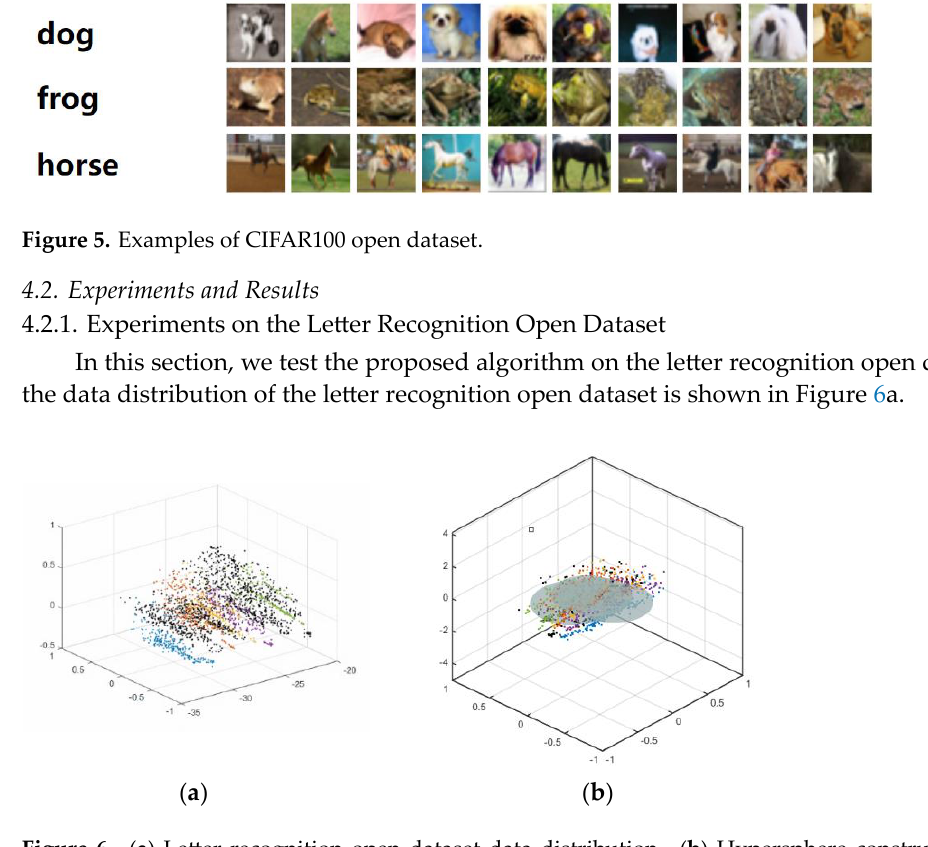
Figure 6. ( a ) Letter recognition open dataset data distribution. ( b ) Hypersphere constructed by SVDD.